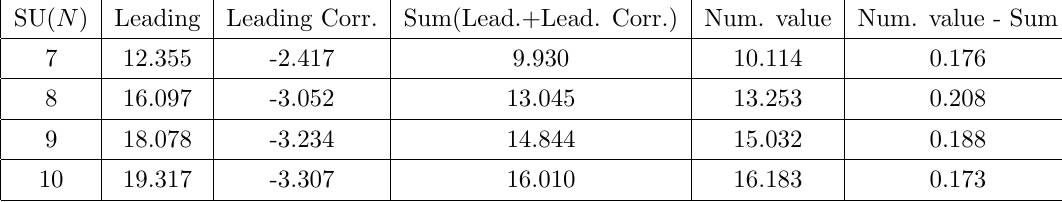
N 10). (cid:20) (cid:20)